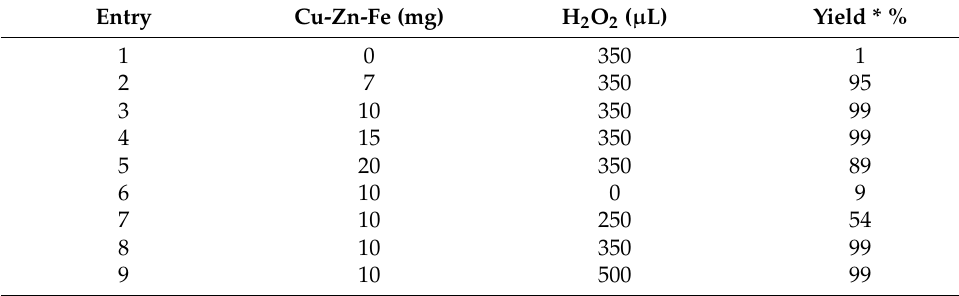
Table 2. Quantitative optimization of Cu-Zn-Fe and oxidant amount.